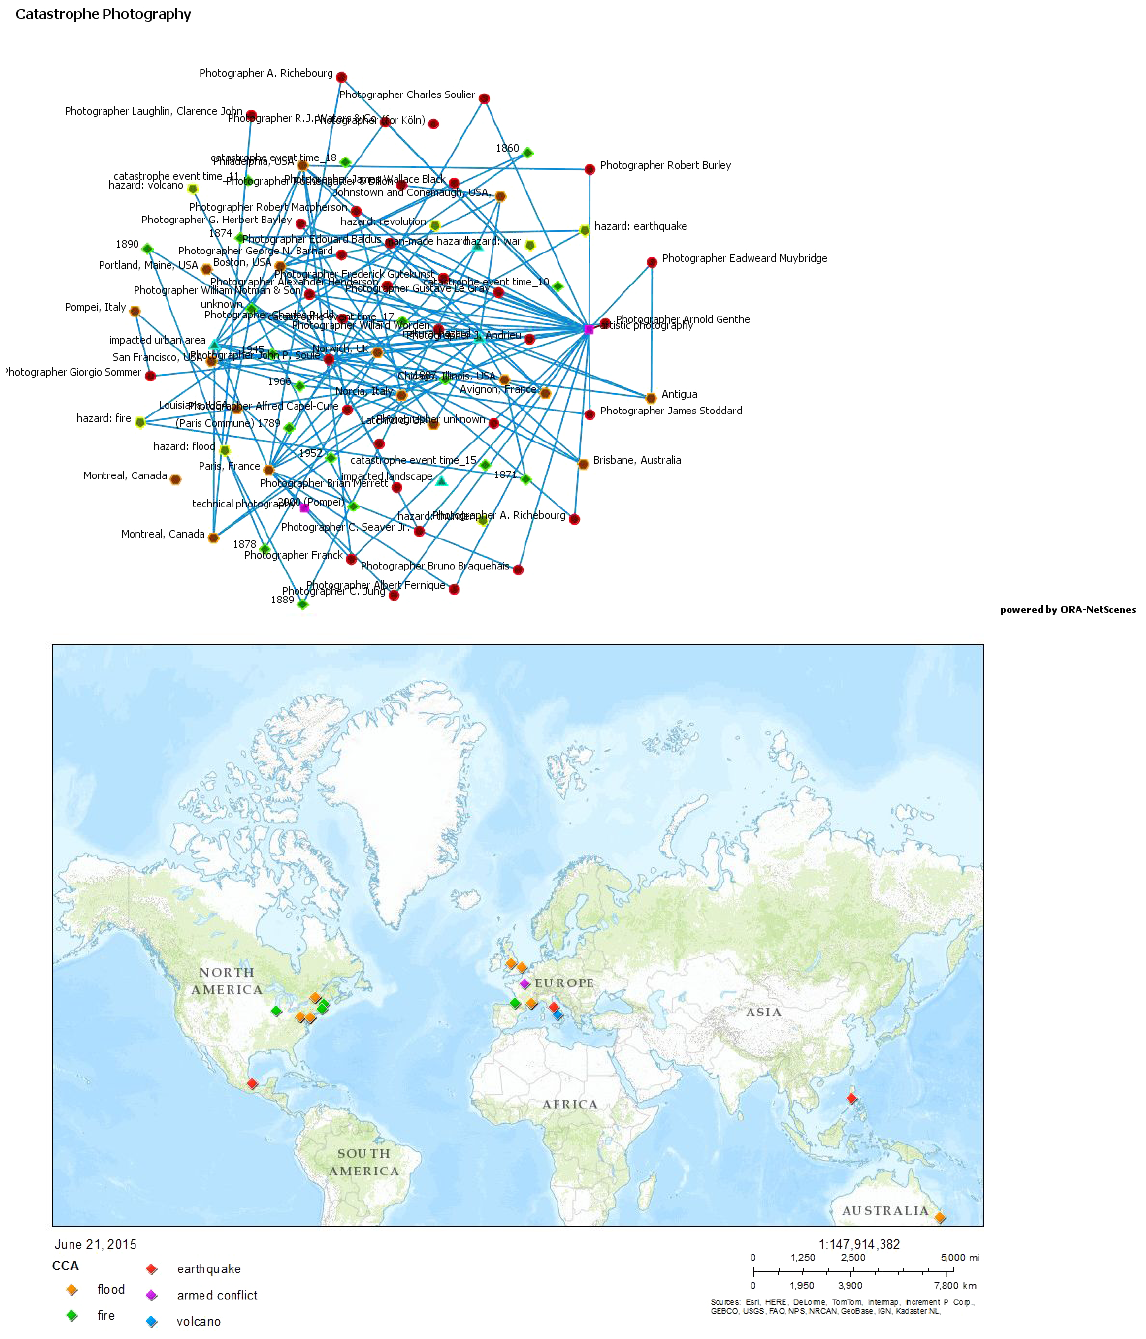
Figure 6. Historical network research of catastrophe photography. Above: the network method we propose applied for the locations on the bottom using an ontology of data connected to the